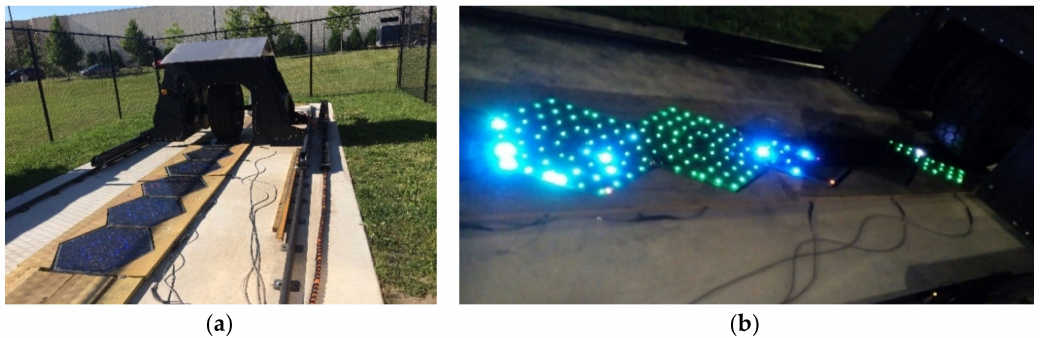
Figure 7. Light emitting diode status ( a ) on 9 July 2018 (serial number 015A-015F depicted from front to back) and ( b ) on 18 September 2018 (S / N’s 015A-015F depicted from left to